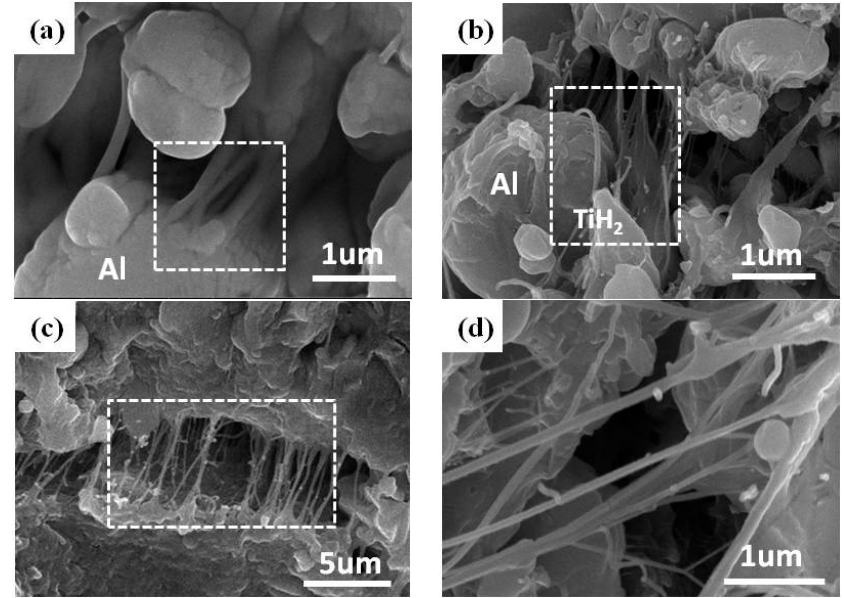
Figure 8. SEM micrographs of type B samples: ( a ) the interior structure before SHPB tests; ( b ) the separation of Al/TiH 2 particles from the PTFE matrix after SHPB tests; ( c ) fracture of the PTFE matrix after the impact; ( d ) network of PTFE nano-fibers.